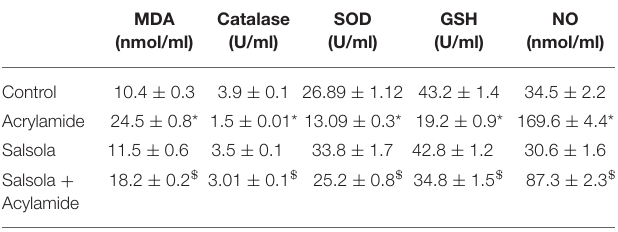
TABLE 4 | Protective effects of Salsola extract against acrylamide induced alterations on serum MDA, catalase GSH and NO and SOD levels.